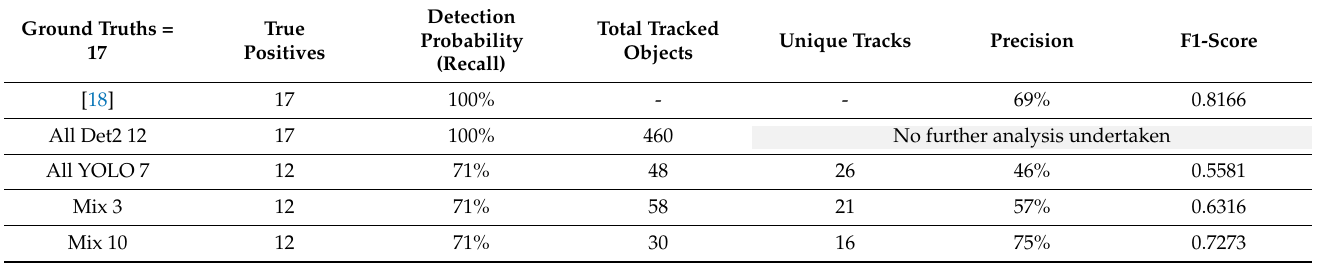
Table 5. Performance metrics for selected ensembles compared to Ref.